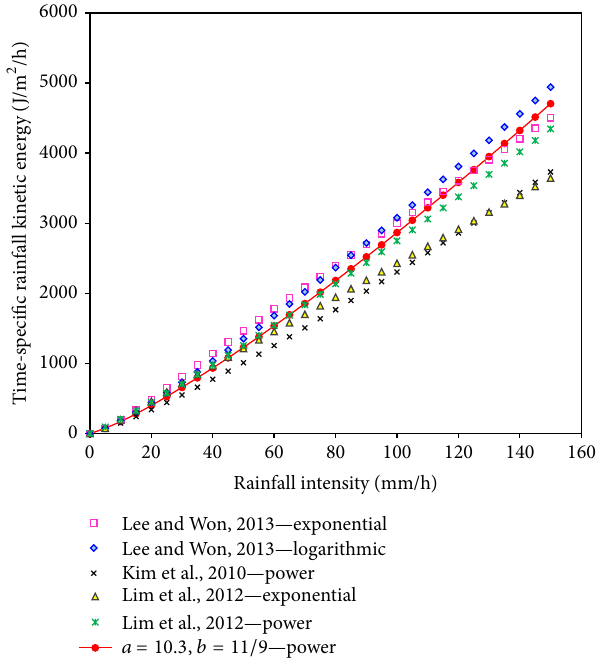
Figure 3: Comparison between time-specific kinetic energies calcu- lated by empirical equations used in soil erosion models and time- specific kinetic energy simulated by universal power law according to rainfall intensity.